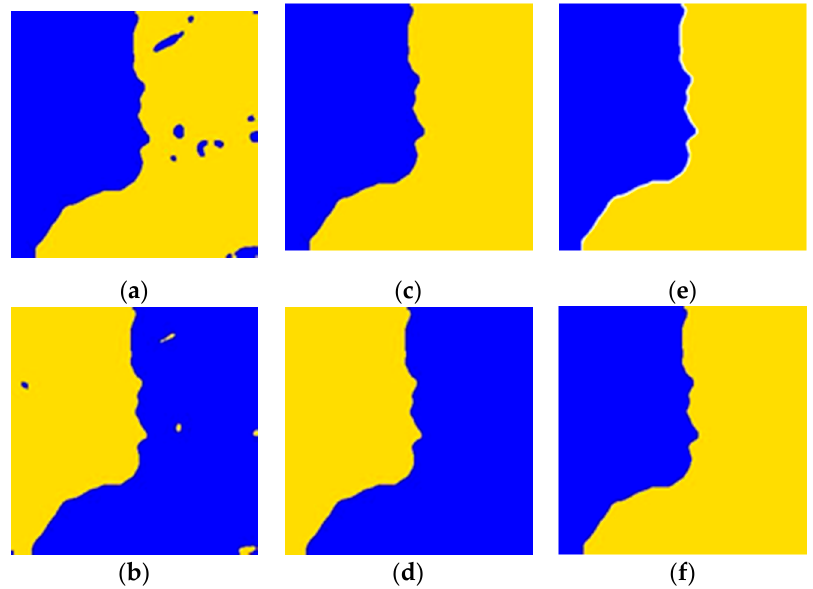
S ; ( b ) binarized clarity score map ' S ; ( c ) standard Figure 4. ( a ) Binarized clarity score map S (cid:48) ; ( b ) binarized clarity score map S (cid:48) ; ( c ) standard normalized Figure 4. ( a ) Binarized clarity score map ' B A A B clarity score map S (cid:48)(cid:48) ; ( d ) standard normalized clarity score map S (cid:48)(cid:48) ; ( e ) initial decision map (cid:101) D ; ( f ) final S ; ( d ) standard normalized clarity score map '' S ; ( e ) initial decision normalized clarity score map '' B A A B decision map D  ; ( f ) final decision map D . map D